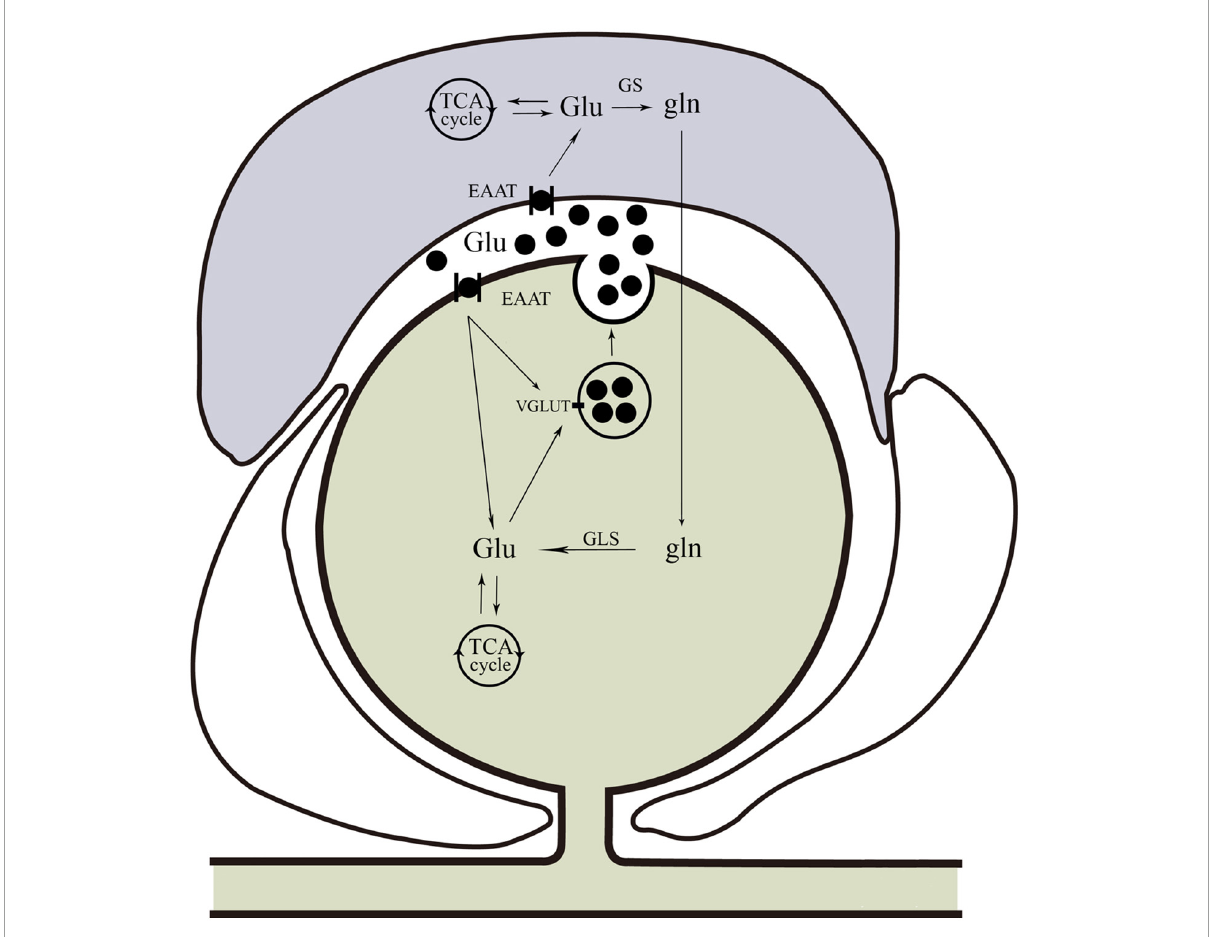
FIGURE2 Glutamine cycle in the trigeminal nervous system. Glu can be taken up by neurons or glia. In neurons, glutamate is taken up by EAAT. Satellite glial cells take up glutamate via EAAT for conversion to Gln via GS. Glutamine can be transported back to neurons for conversion to Glu by GLS, and then Glu can be packaged into vesicles by VGLUT. In addition to the glutamine cycle, neuron and glial cells also produce glutamate via interactions with the neuronal TCA cycle. Glu, glutamate; EAAT, excitatory amino acid transporter; Gln, glutamine; GS, glutamine synthetase; GLS, glutaminase; VGLUT, vesicular glutamate transporters; TCA, tricarboxylic